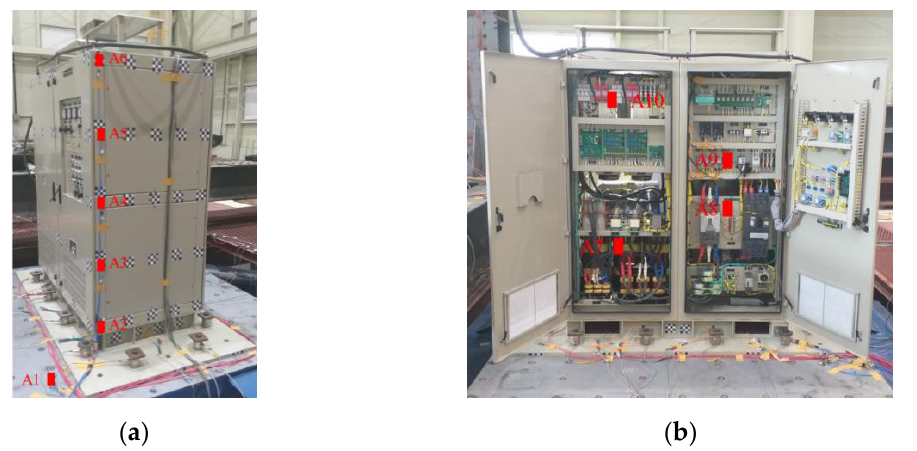
Figure 1. Dimensions and shape of tested battery charger (units: mm).